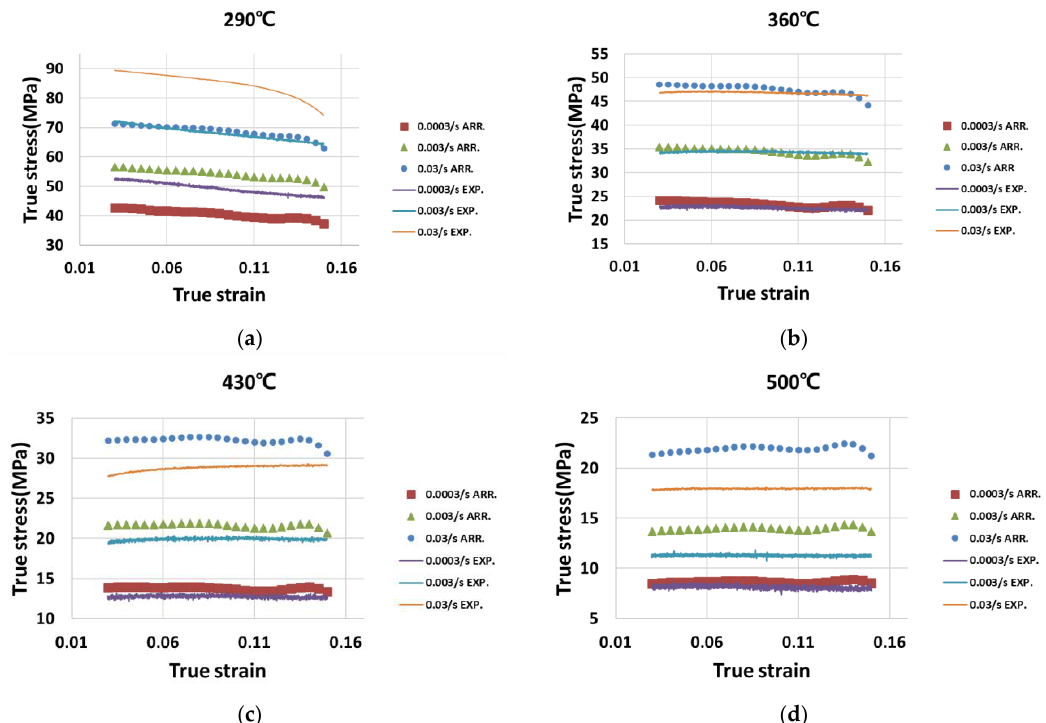
Figure 5. True stress–strain curves by Arrhenius equation at ( a ) 290 °C, ( b ) 360 °C, ( c ) 430 °C, and ( d ) 500